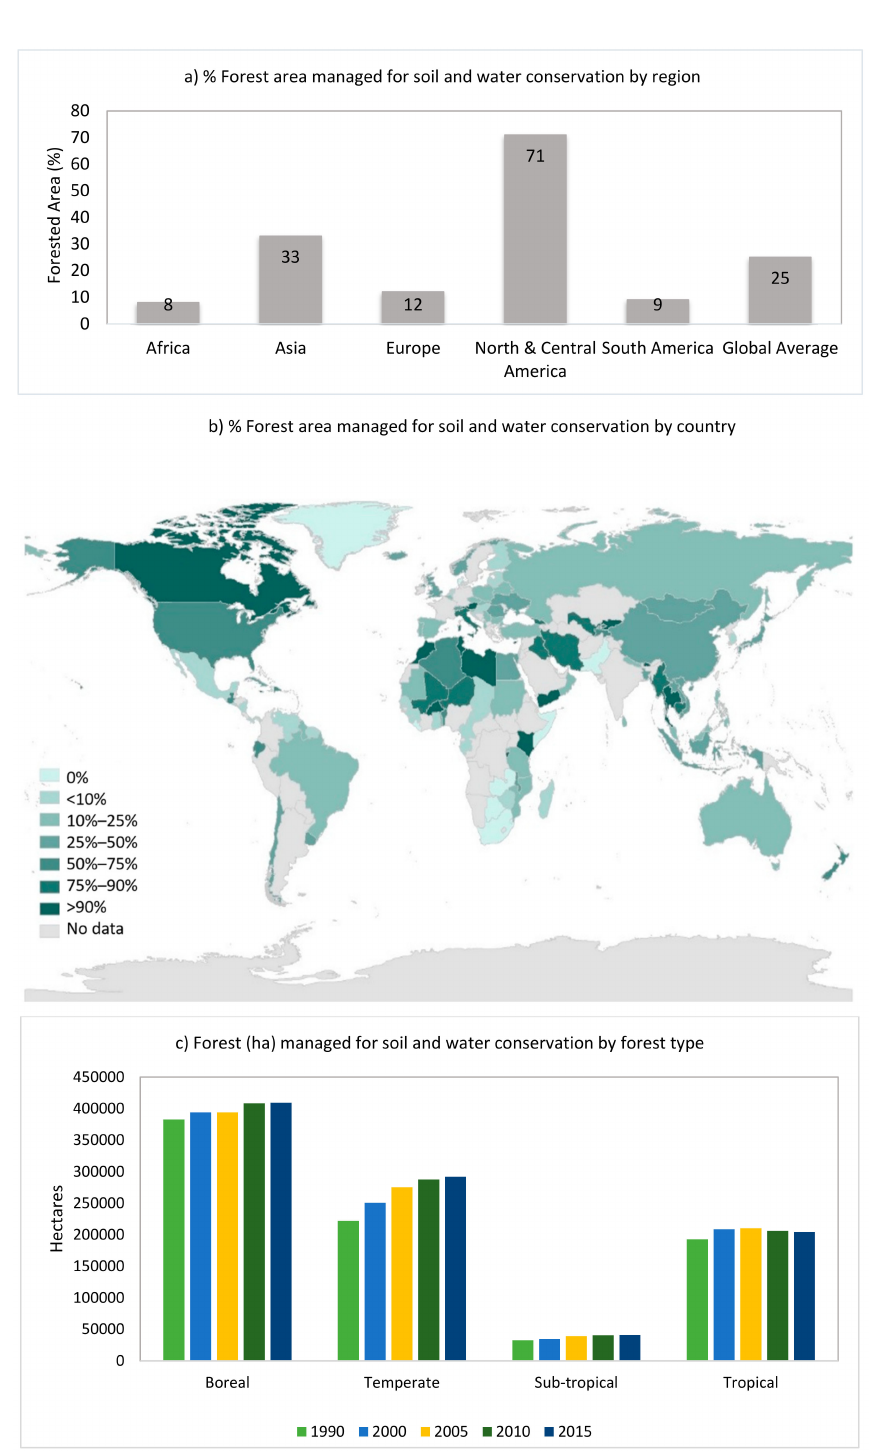
Figure 5. ( a ) Percentage area of forests for soil and water protection by region; ( b ) percentage area of forests for soil and water conservation by country, shown graphically, and, ( c ) number of hectares of forests for soil and water protection by forest type. Data sourced from FAO (2015)